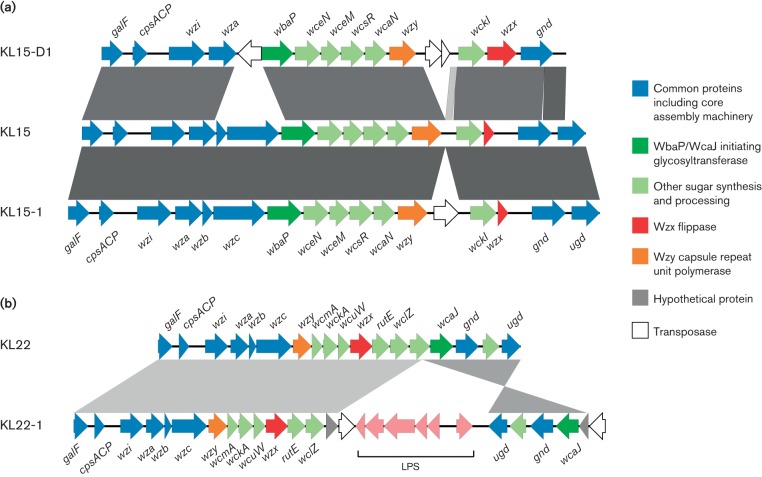
Example K-locus structures and comparisons. CDSs are represented as arrows coloured by predicted function of the protein product and labelled with gene names where known. Grey bars indicate regions of similarity identified by blast comparison, darker shading indicates higher sequence identity. (a) Comparison of deletion variant KL15-D1 and IS variant KL15-1 with the synthetic KL15 locus. (b) Comparison of the IS variant KL22-1 with the K-type reference KL22 locus. The downstream LPS (LPS synthesis) operon (pink arrows) has been translocated into the K-locus.